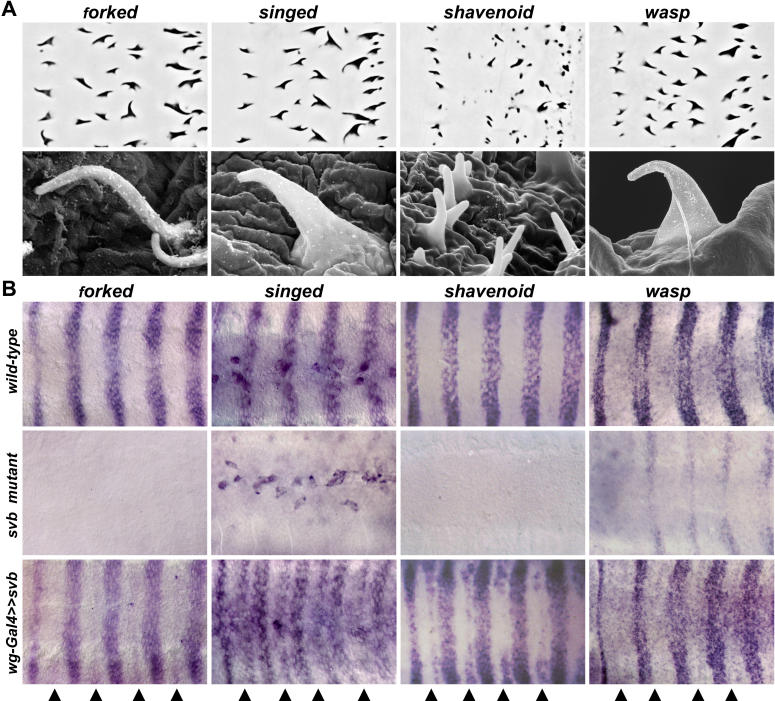

svb Directs the Expression of Genes Encoding Actin-Remodeling Proteins Required for Denticle Formation(A) Cuticle preparations showing denticle morphology in f36a sn3 sha1 and wsp3 mutants. All views correspond to the same region, i.e., the ventral-most region of the A4 segment. Close-ups are scanning electron microscopy magnification of a representative denticle from the fourth row of denticles.(B) mRNA expression of forked, singed, shavenoid/kojak, and wasp in the ventral embryonic abdomen (A2–A6) of wild-type, svb mutants, and embryos expressing svb in wg cells, as observed from in situ hybridization. Arrowheads point to wg cells. Anterior is to the left in all pictures.